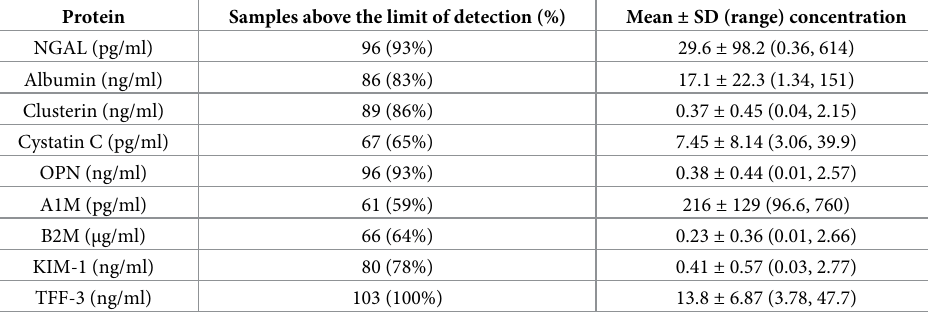
Table 2. Descriptive statistics of each protein measured in children’s urine samples.